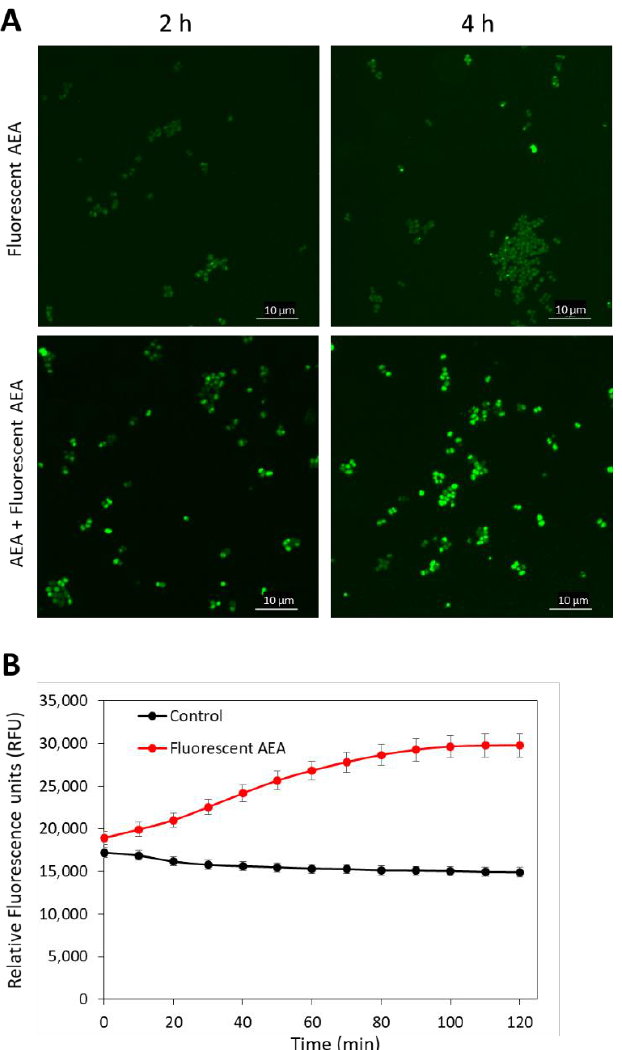
Figure 4. AEA increases the intracellular concentration of fluorescent AEA. ( A ). Spinning disk confocal microscopy of MDRSA CI-M that has been treated with 5 µg/mL fluorescent AEA alone (two upper panels) or in the presence of 50 µg/mL AEA (two lower panels) for 2 and 4 h. The green fluorescence was visualized using the 488 nm excitation laser and the green filter. ( B ). MDRSA CI-M was either untreated or exposed to 5 µg/mL fluorescent AEA and incubated in PBS supplemented with 1% D-glucose. The fluorescence intensity was measured with excitation/emission of 488 nm/530 nm each 10 min for 2 h in a M200 infinite Tecan plate reader.